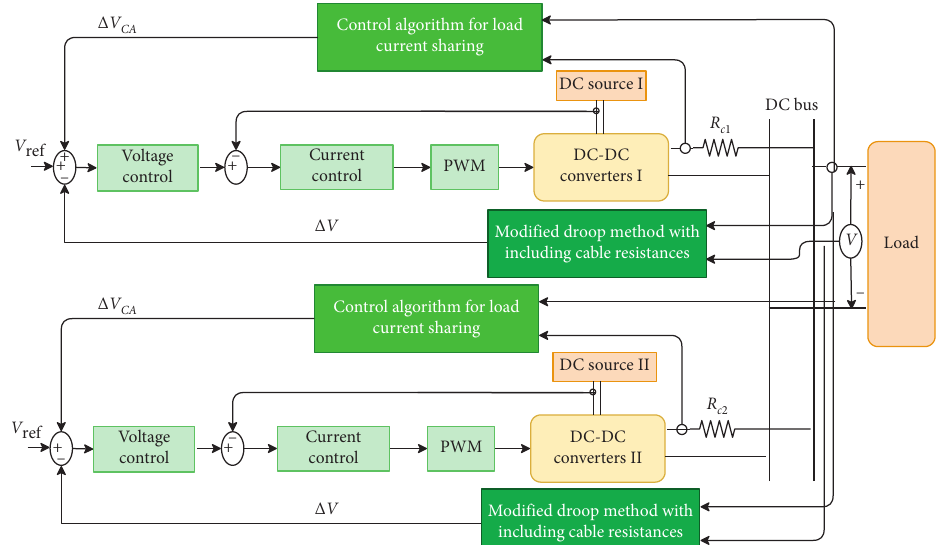
Figure 7: Block diagram of two parallel-connected boost converters with the proposed algorithm.